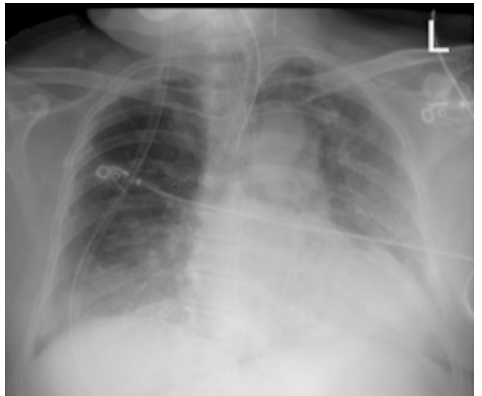
Figure 4. Bilateral—not diffuse—hazy infiltrates with a left predominance.